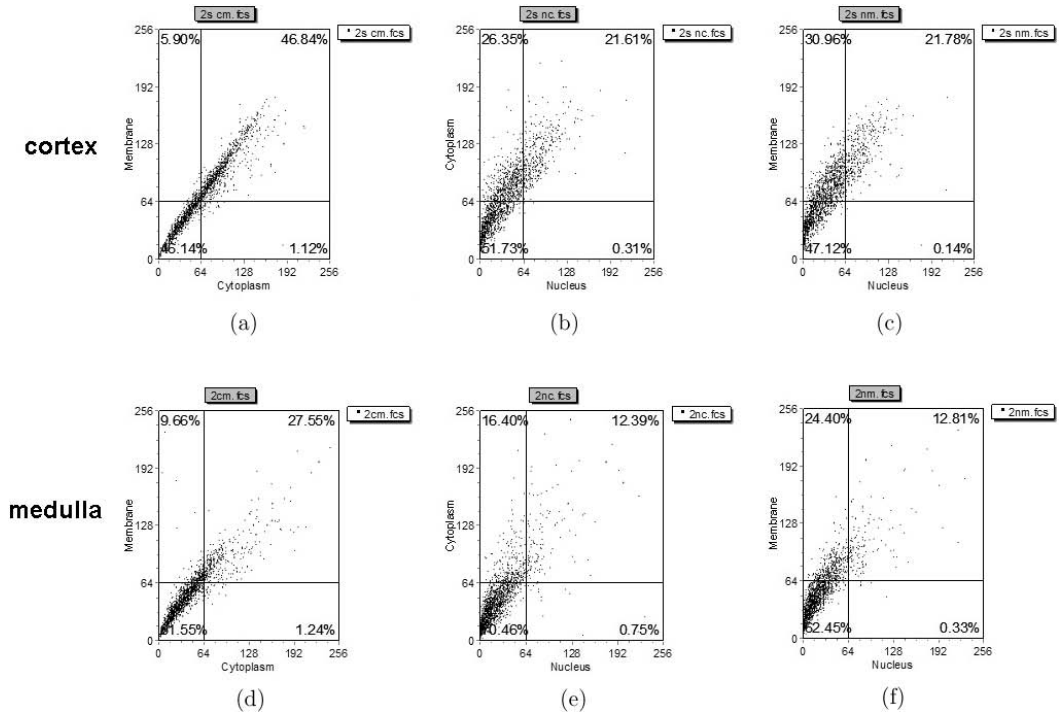
Fig. 4. Au – Ft °uorescence signal at di®erent kidney cell regions. Au – Ft °uorescence signal intensity data were \digitally" extracted from probes staining images of nu/nu kidney sections assisted with the colocalization of cell membrane staining (Dio) and nuclei staining (DAPI). (a), (b) and (c) Scatter plots of Au – Ft °uorescence signal distribution among cell membrane, cytoplasm and nuclei of renal cortex cells; (d), (e) and (f) Scatter plots of Au – Ft °uorescence signal distribution among cell membrane, cytoplasm and nuclei of renal medulla cells. Table 1. The Au – Ft °uorescence signal intensity on kidney sections. Renal cortex Renal